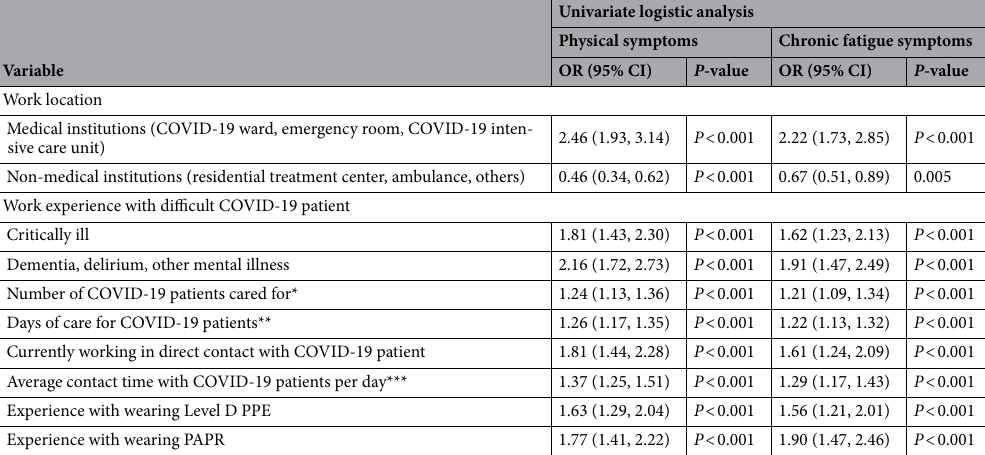
Table 7. Univariate logistic analysis of physical (PHQ-15 ≥ 10) and chronic fatigue (FSS ≥ 3.22) symptoms after the COVID-19 outbreak according to patient care work. CI confidence interval, PPE personal protection equipment, PAPR powered air-purifying respirator. *0, 1–10 patients, 11–20 patients, more than 20 patients, as the number of patients to care increases from a small group to a large group. **0, 1–29 days, 30–59 days, 60–89 days, more than 90 days, as the number of days of care for COVID-19 patients increases from a small group to a large group. ***No, less than 30 min, 30 min–2 h, 2–6 h, more than 6 h, as the contact time with COVID-19 patients per day increases from a small group to a large group.